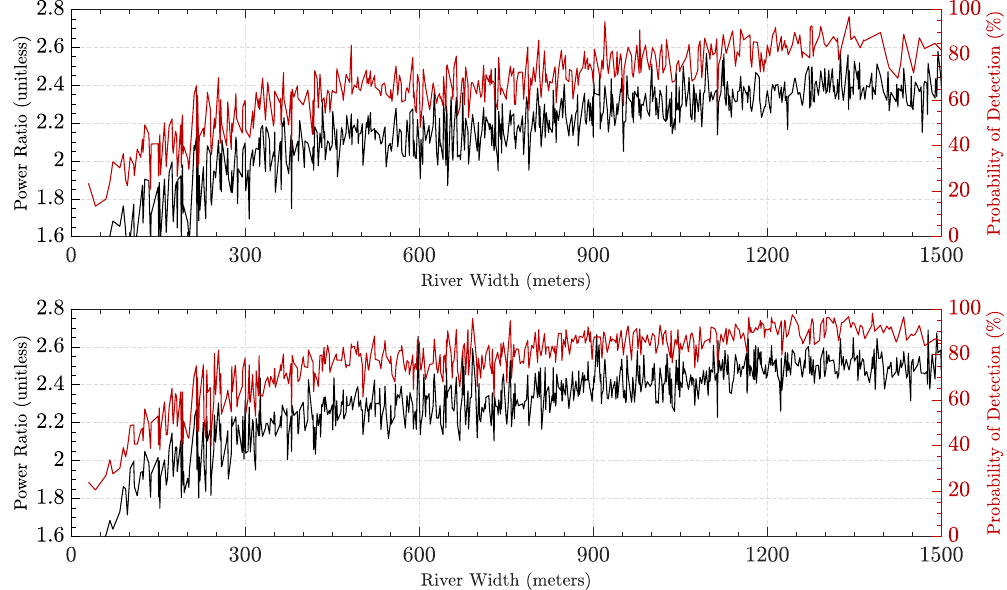
Figure 7. Analysis deriving from the NARWidth data set illustrating effects of varied river widths on the CYGNSS Level-1 coherence metric and probability of detection. ( Top ) Across a sixth month period from 1 September 2018 to 28 February 2019, exclusively comprising 1 Hz data. ( Bottom ) Across a sixth month period from 1 September 2019 to 2 February2020, exclusively comprising 2 Hz